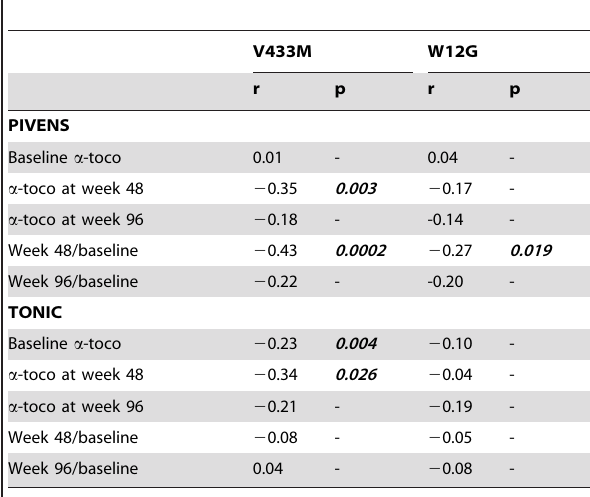
Table 3. Association between CYP4F2 polymorphisms and plasma a -tocopherol